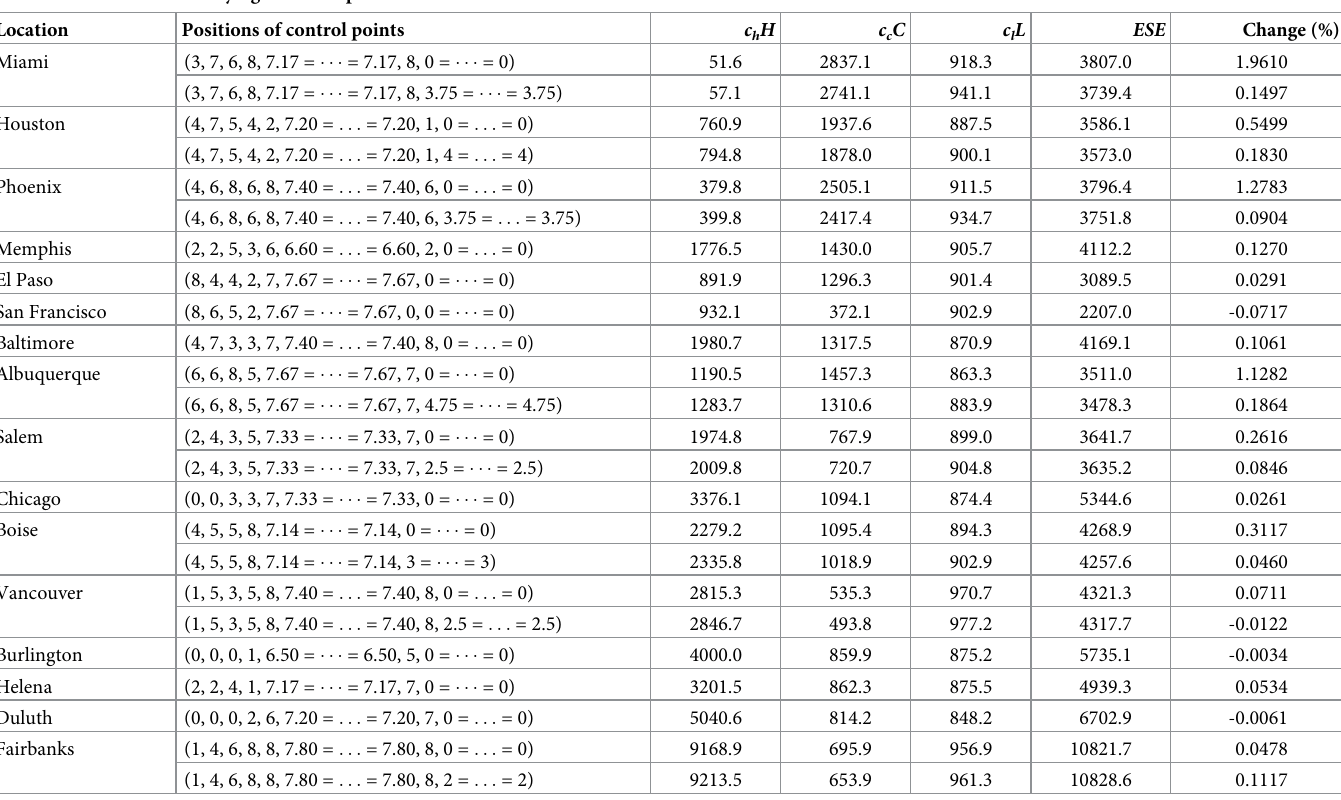
Table 9. The effects of rectifying the lower part of eastern fin. Location